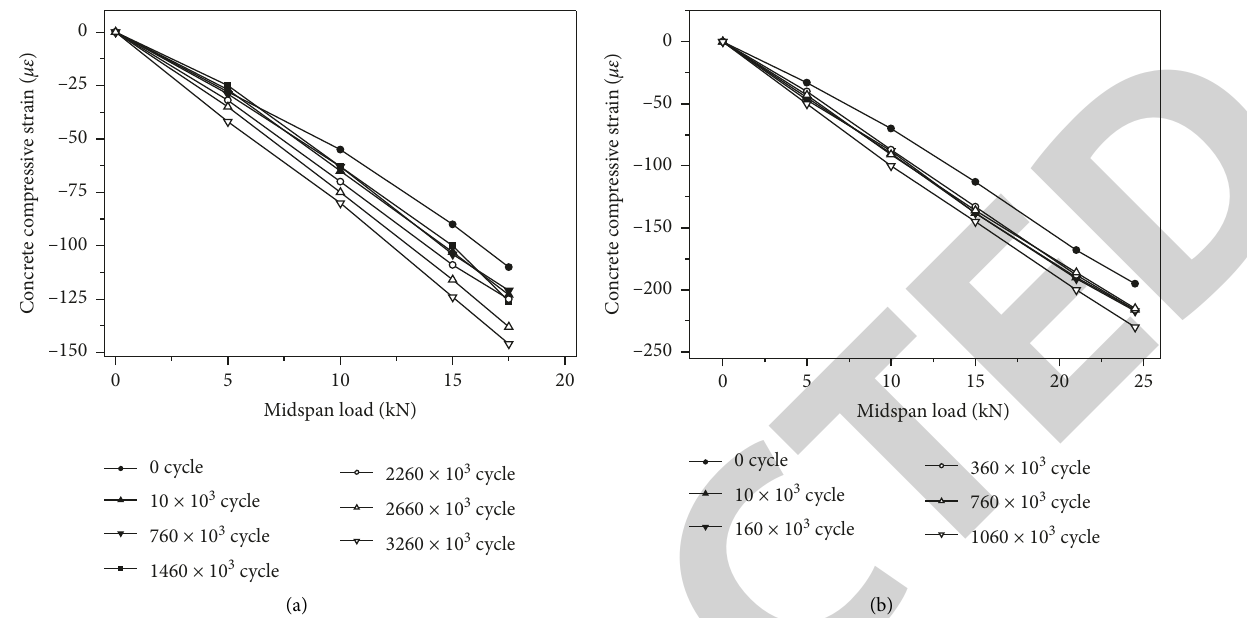
Figure 9: Concrete strain evolution law of typical test girders. (a) Relationship between flange compressive strain and load in the F-4 girder. (b) Relationship between flange compressive strain and load in the F-5